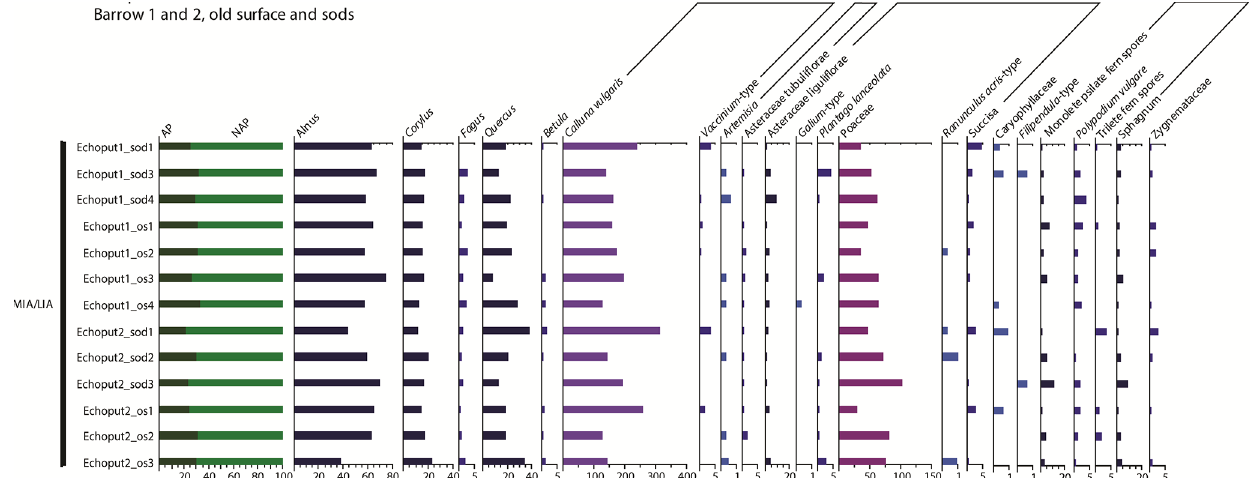
Figure 8. Pollen spectra from the sod and old surface samples taken from Echoput barrow 1 and 2.